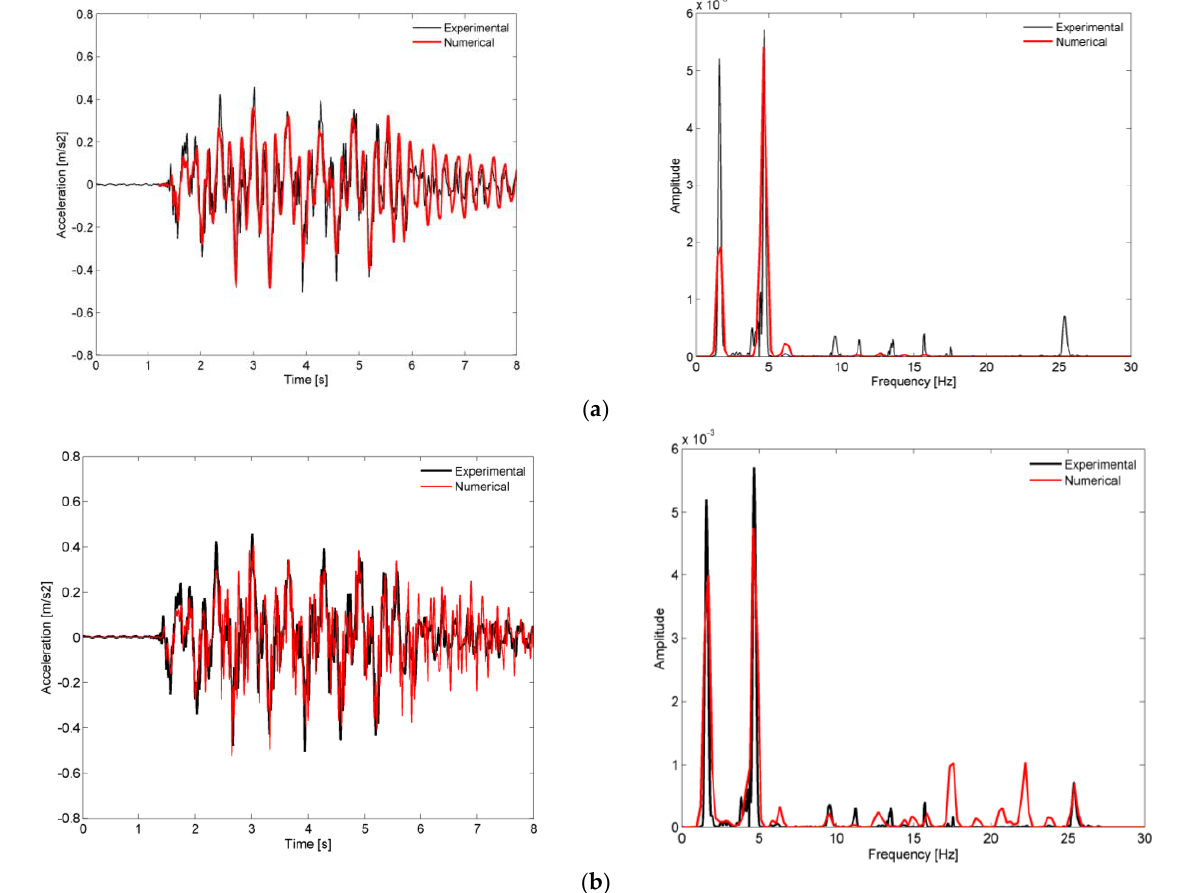
Figure 20. Comparison of the records of the vertical acceleration on the deck (location A1) and the respective auto-spectra, obtained experimentally and numerically, for the passage of the Alfa Pendular train at a speed of 150 km/h: ( a ) without irregularities; ( b ) with irregularities.